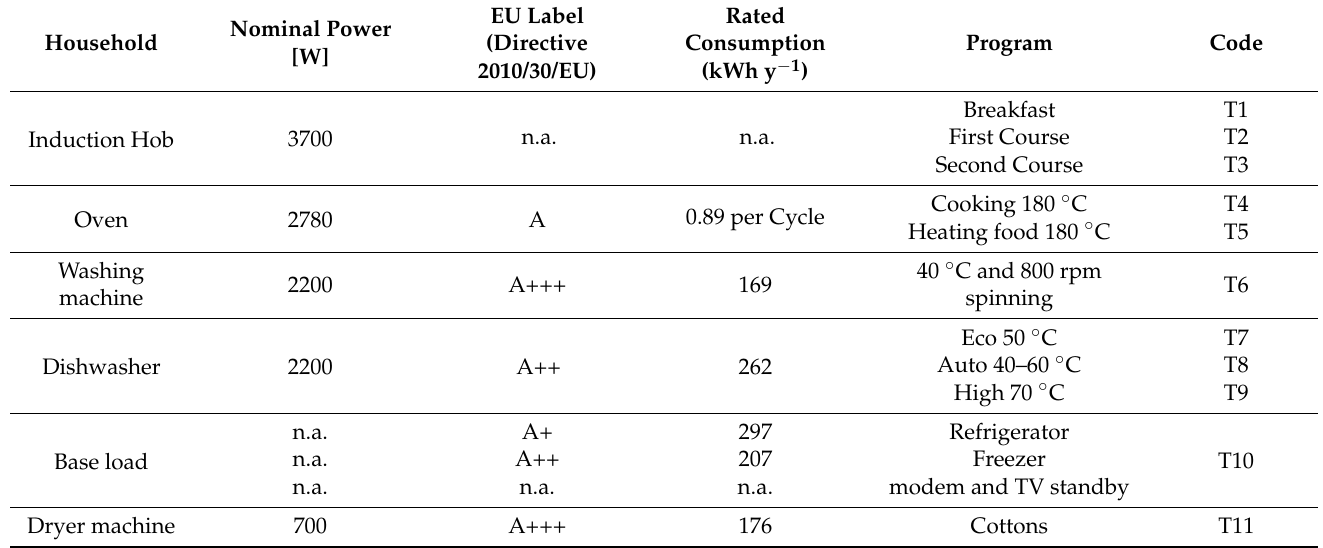
Table 3. Geometrical characteristics of the single-family building.